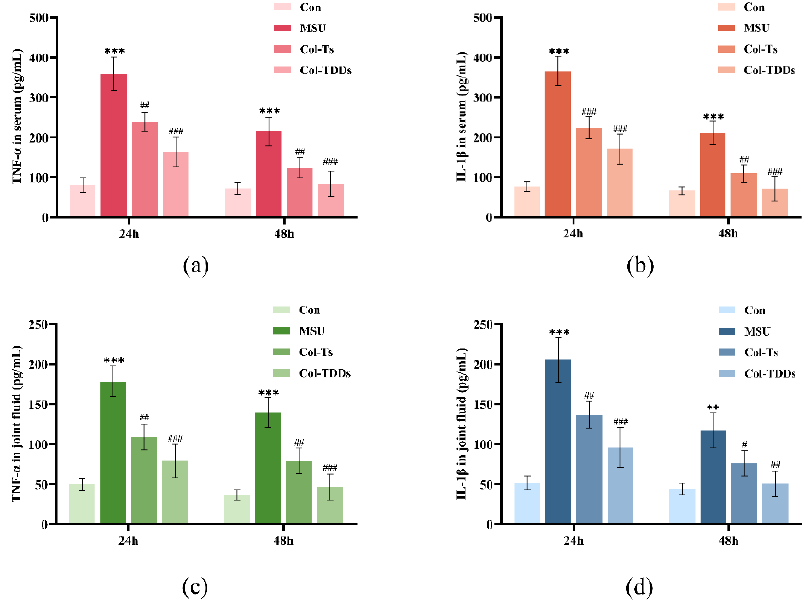
Figure 6. Effect of colchicine drug-in-adhesive patches and colchicine tablets on the levels of key inflammatory factors ( a ) TNF- α in rat serum and ( b ) IL-1 β in rat serum, and ( c ) TNF- α in rat joint fluid and ( d ) IL-1 β in rat joint fluid. Data are expressed as the mean ± SD; ** p < 0.01, *** p < 0.001 vs. Con. # p < 0.05, ## p < 0.01, ### p < 0.001 vs. MSU.